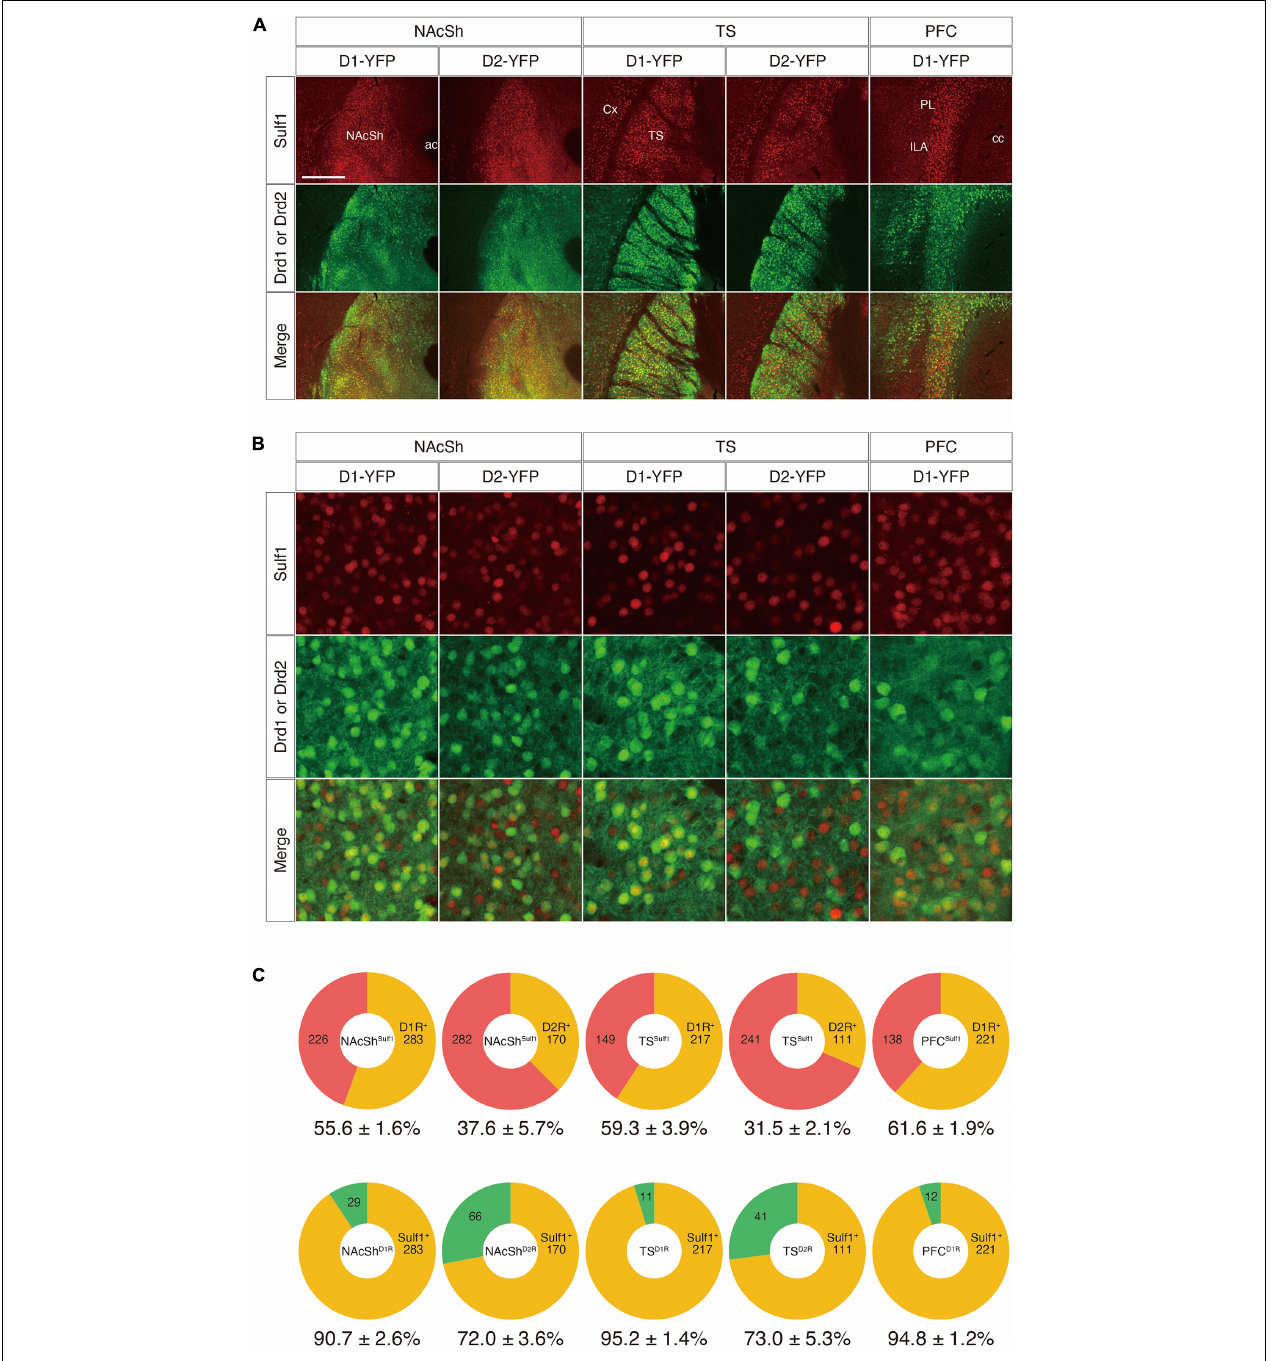
FIGURE 8 | Co-expression of Sulf1 and the dopamine D1/D2 receptors. (A) Confocal microscopic images of the coronal brain slices. Representative images from the nucleus accumbens shell (NAcSh), posterior tail of the striatum (TS), and prefrontal cortex (PFC) are shown. Sulf1 -expressing cells were identified by immunostaining β -galactosidase (red) by means of lacZ inserted in the Sulf1 locus ( Sulf1 lacZ / + ). D1R- or D2R-expressing neurons were identified by immunostaining GFP (green) in Drd1- or Drd2-YFP mice. Co-localization of Sulf1 and Drd1/2 were clearly observed. ac, anterior commissure; cc, corpus callosum; Cx, cerebral cortex; ILA, infralimbic area; PL, prelimbic area. (B) High magnification images of the NAcSh, TS, and PFC regions after immunostaining β -galactosidase (red) and GFP (green) are shown. (C) The upper panels show the percentages of D1R- or D2R-positive (orange) and D1R- or D2R-negative (red) cells in the Sulf1 -expressing cells. The lower panels show the percentages of Sulf1 -positive (orange) and Sulf1 -negative (green) cells in the D1R- or D2R-expressing cells. Cell counting was conducted for two randomly selected ROIs for all regions from three mice. The numbers in the circular graphs indicate the number of cells in each category. The numbers below the graphs indicate the percentages of co-localization. The scale bars indicate 400 µ m (A) and 50 µ m (B) . Approximate AP levels from the bregma (in mm) in (A,B) are 1.0 (NAcSh), –1.0 (TS), and 2.0 (PFC).